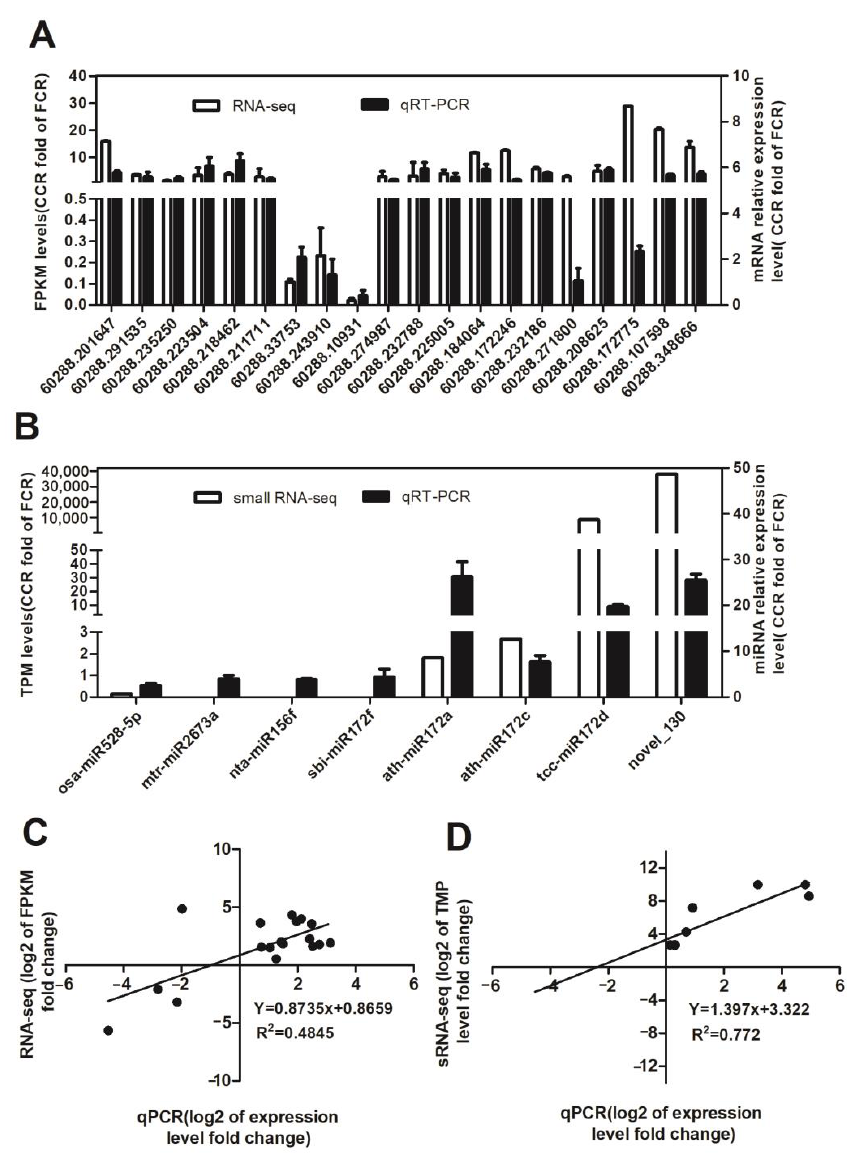
Figure 7. qPCR verifies the quality of transcriptome sequencing and small RNA sequencing in the roots of P. odoratum . ( A ) Results from RNA-sequencing on transcript levels and qPCR of 20 unigene genes that regulate the phenolic acid synthesis. ( B ) The small RNA sequencing levels and qPCR results of 8 miRNAs from small RNA-sequencing, which regulates phenolic acid synthesis. The white bar graph represents the normalized result (CCR vs FCR) of the sample in RNA-seq of ( A ) or sRNA-seq (left y-axis) of ( B ), whereas a black bar graph represents the relative expression level (right y-axis). ( C ) The log2 expression ratios from RNA-seq (y-axis) and qPCR (x-axis) were used to generate scatterplots. ( D ) The log2 expression ratios from small RNA-seq (y-axis) and qPCR (x-axis) were used to generate scatterplots. In the left y-axis are the relative gene expression levels analyzed by qPCR (black lines). FCC stands for the root samples of the first cropping, and CCR stands for root samples of consecutive cropping.